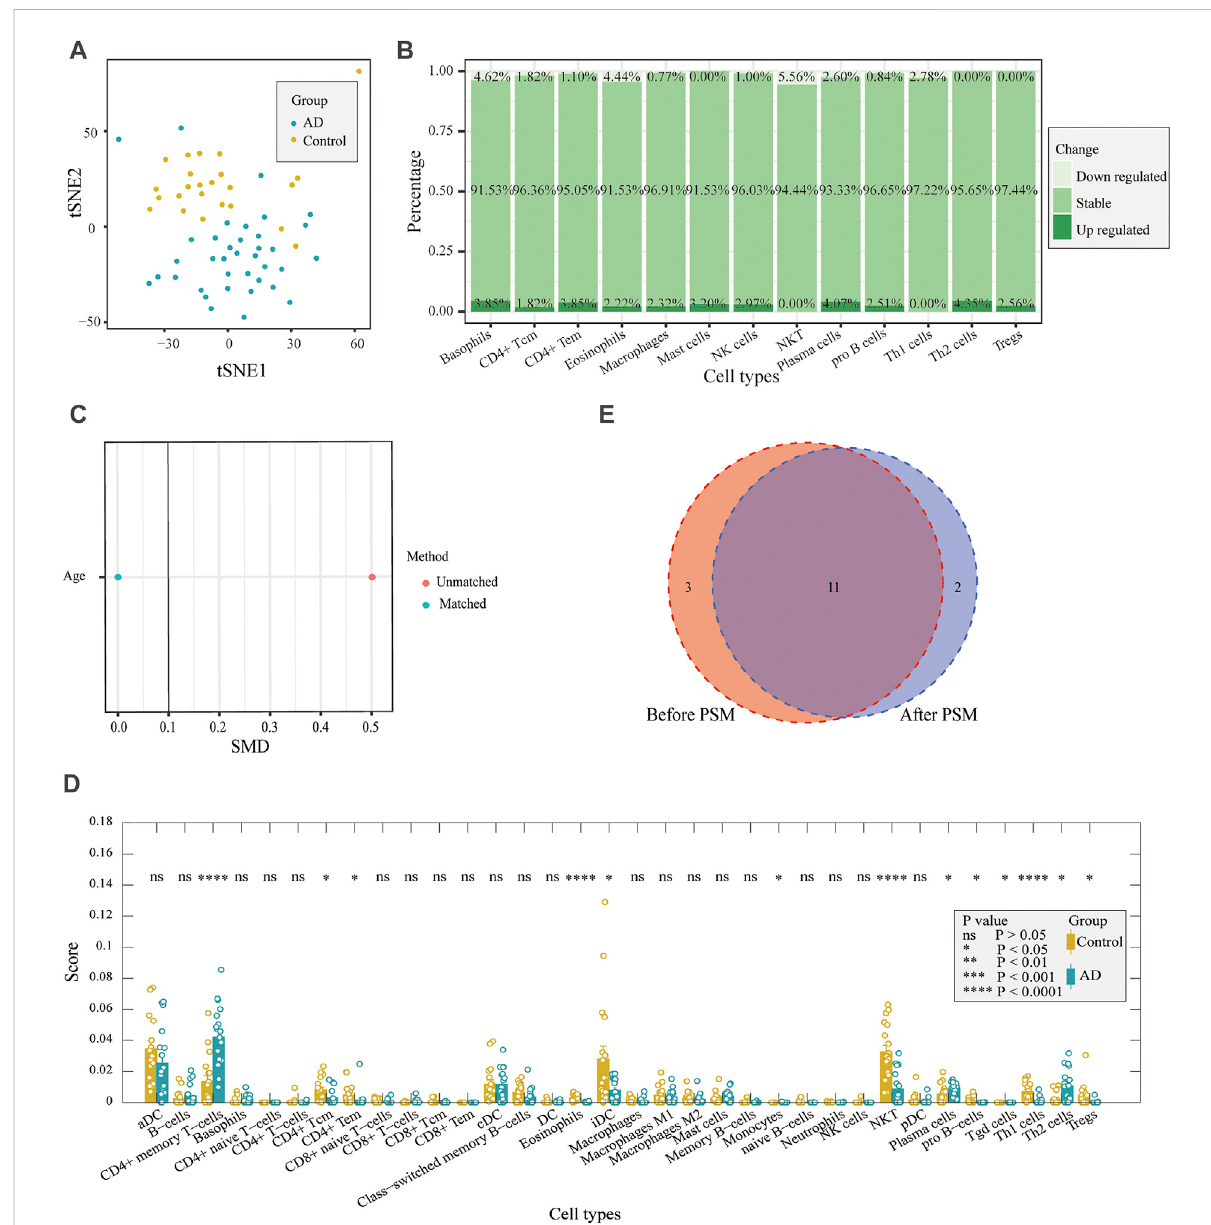
FIGURE 3 Correlation between differentially expressed marker genes and corresponding immune cells. (A) tSNE plot for AD and control individuals by using immune cell markers. (B) . DEG proportions in immune cell markers. (C) Difference in age was reduced after PSM. (D) Comparison of immune cell scores between AD and control samples after PSM. (E) Results both before PSM and after PSM are displayed with a Venn diagram. After PSM, changes in 11 immune cell scores were the same as before